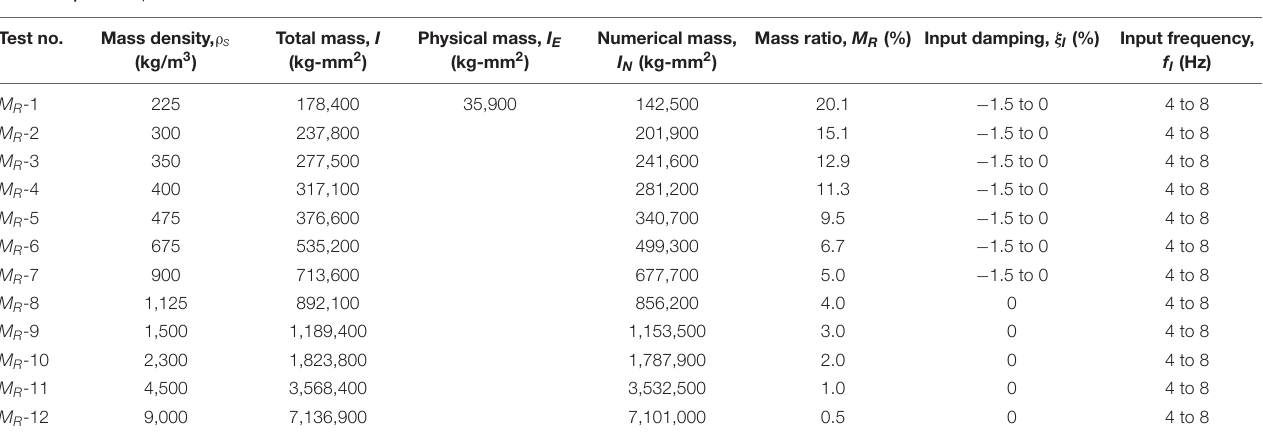
FIGURE 6 | Time history of free vibration test for case ( M R − 7 and ξ I = 0 , f = 6 . 0Hz ) . (A) Complete response history, and (B) response history between 600 ms and 900 ms. TABLE 1 | Control parameters of free vibration